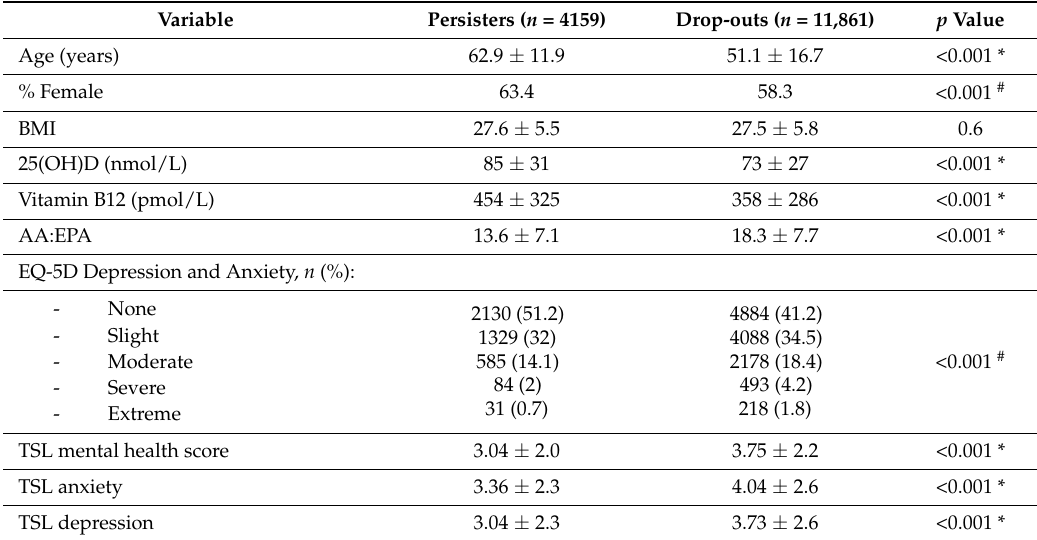
Table 3. Baseline comparison of Participants who stay in the program for one year (Persisters) to those that had a baseline visit only